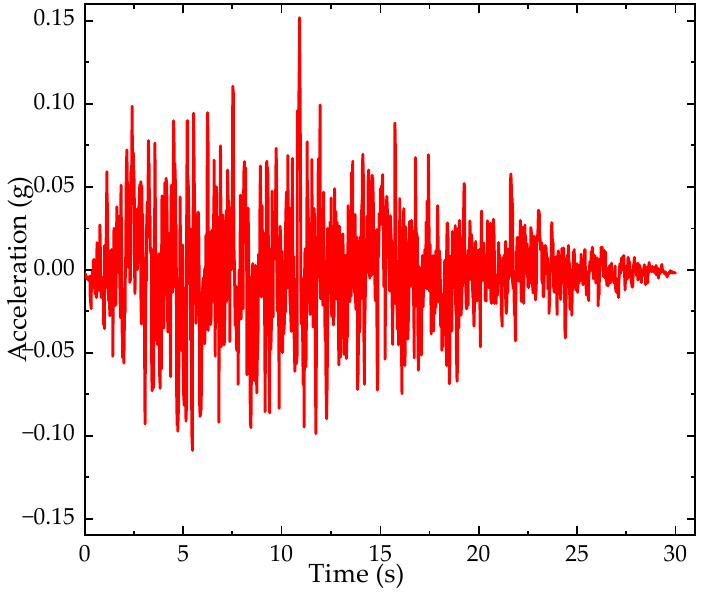
Figure 8. Adjusted time history curve.